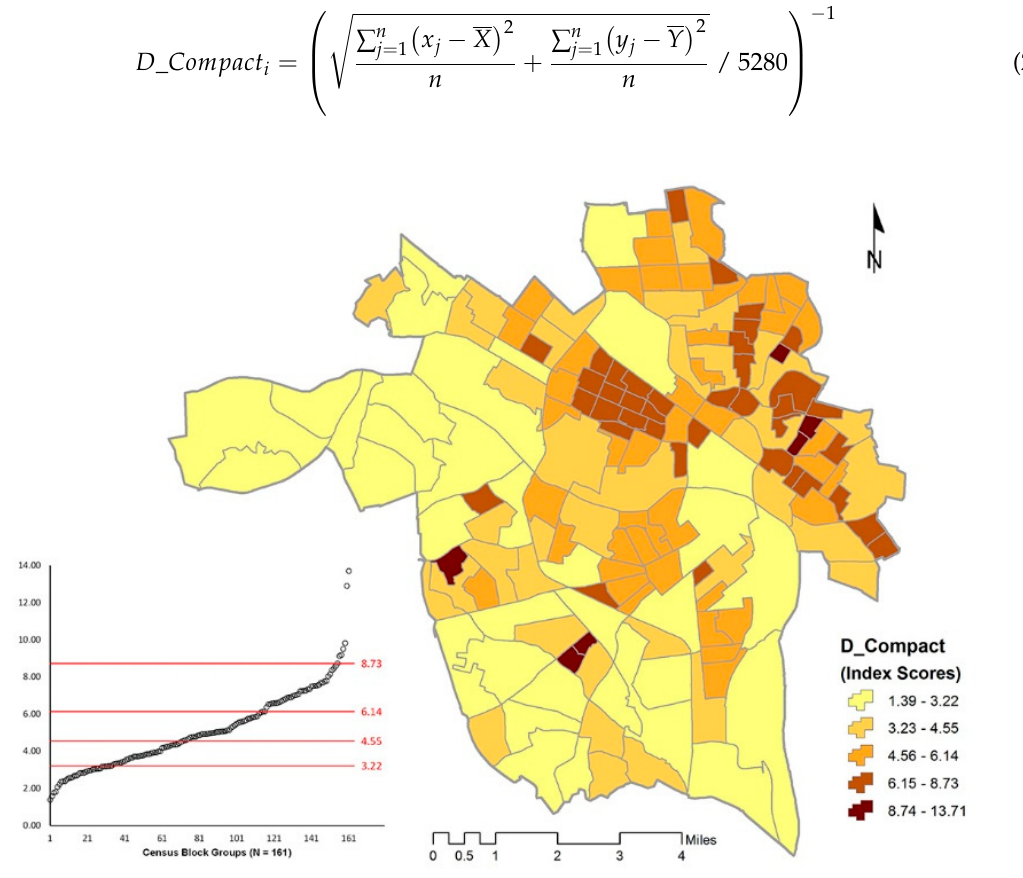
Figure 6. Development compactness of Census Block Groups in the City of Richmond.